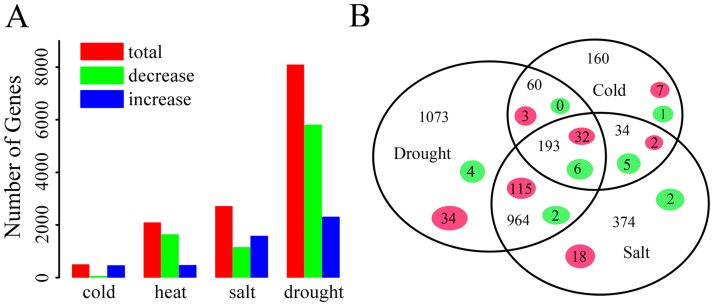
A summary of differentially expressed genes of B. distachyon seedlings under heat, cold, drought and salt stresses.(A) The number of up-/down-regulated genes under four abiotic stresses. Vertical axis indicated the differentially expressed gene numbers. Horizontal axis indicates four stresses. Red, green, and blue bars represented the total, decreased, and increased probe sets, respectively. (B) Venn diagram of differentially expressed genes under four abiotic stresses. Three circles indicate the differentially expressed genes under cold, drought and salt stresses. Numbers in red circles indicated gene numbers co-regulated by heat stress and other stresses, while numbers in green circles indicated the number of BdHsf and BdHsp70 genes co-regulated by heat stress and other stresses in our qPCR experiment.